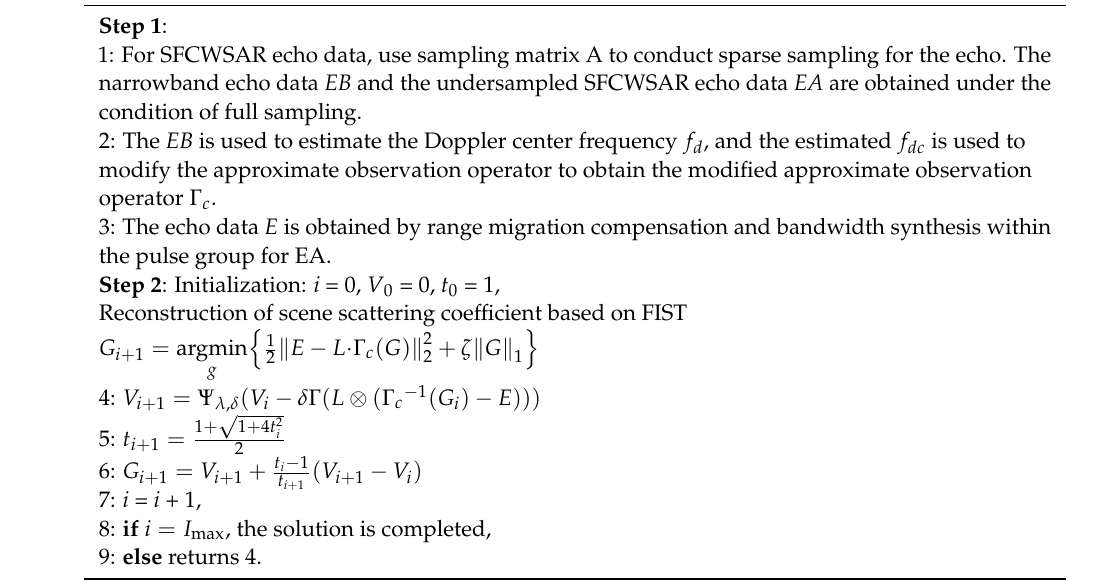
Algorithm 2 Sparse reconstruction algorithm based on range migration compensation and Doppler center frequency correction in the pulse